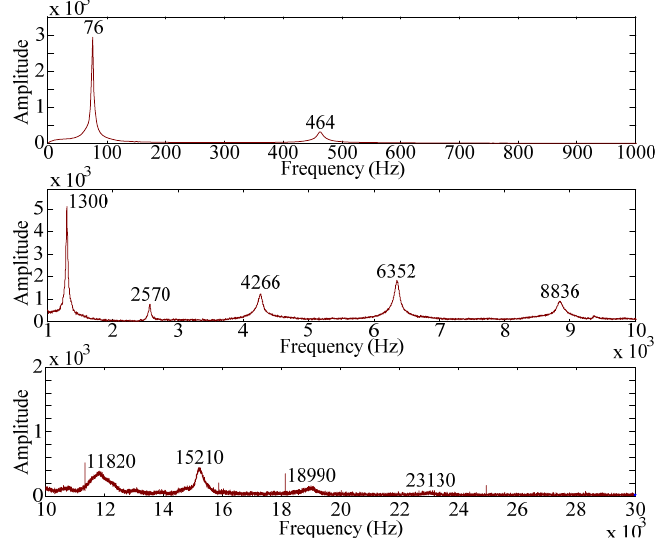
Figure 14. Frequency spectrum of PVDF 20 × 10 with impact on location A.